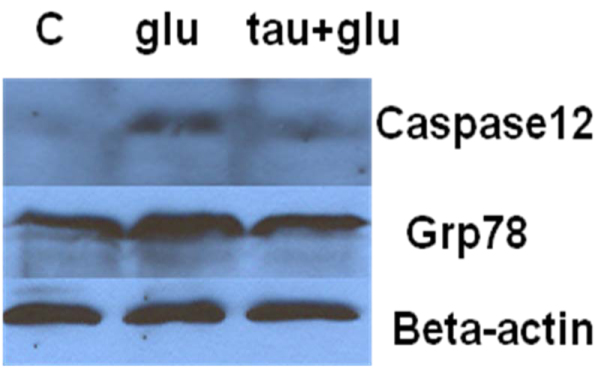
Effect of taurine on glutamate-induced elevated expression of GRP78 and Caspase-12 by Western blot analysis. Primary cortical neurons were preincubated with 25 mM taurine for 1 hour, and then exposed to 100 uM glutamate for 4 hours. Expression of GRP78 protein and caspase 12 was analyzed by Western blot assay. Beta-actin was included to show equal loading. C: Control; glu: Glutamate-treated group; tau+ glu: Same as glu group except pretreated with taurine.